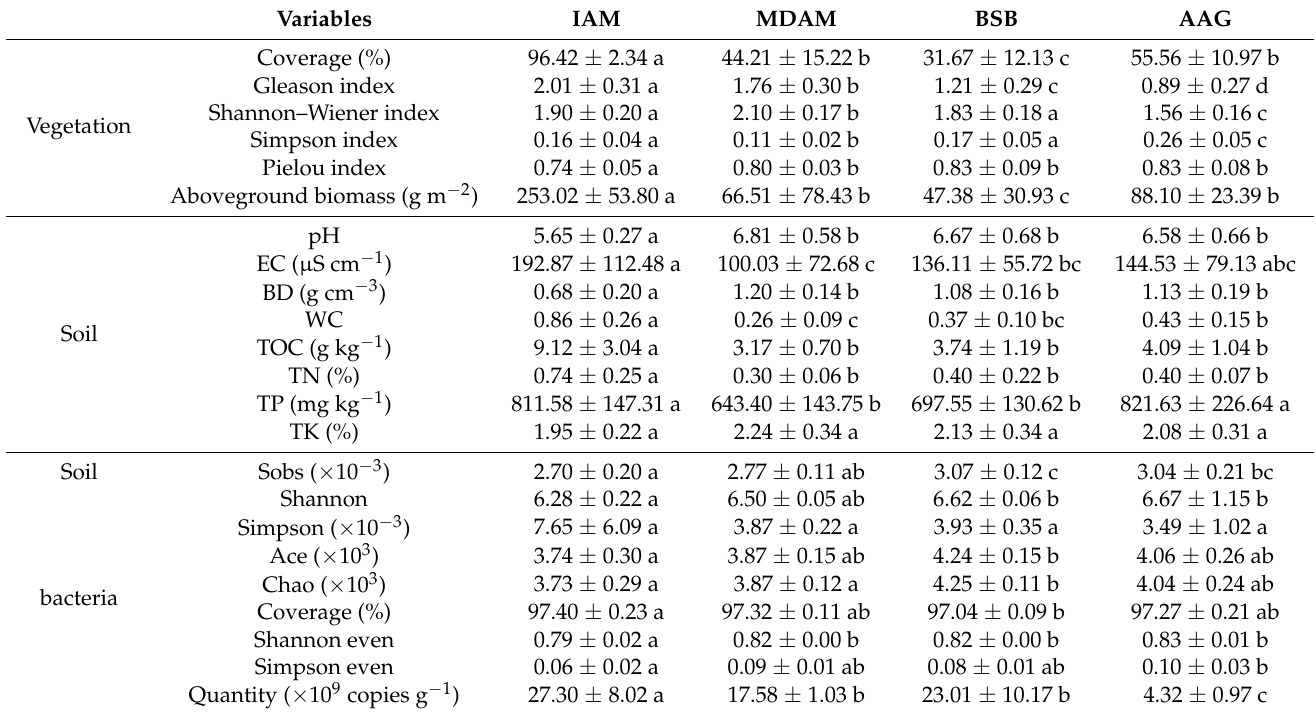
Table 1. Calculated statistics for vegetation–soil–bacteria variables of the alpine meadow under degradation and cultivation (means ± the standard